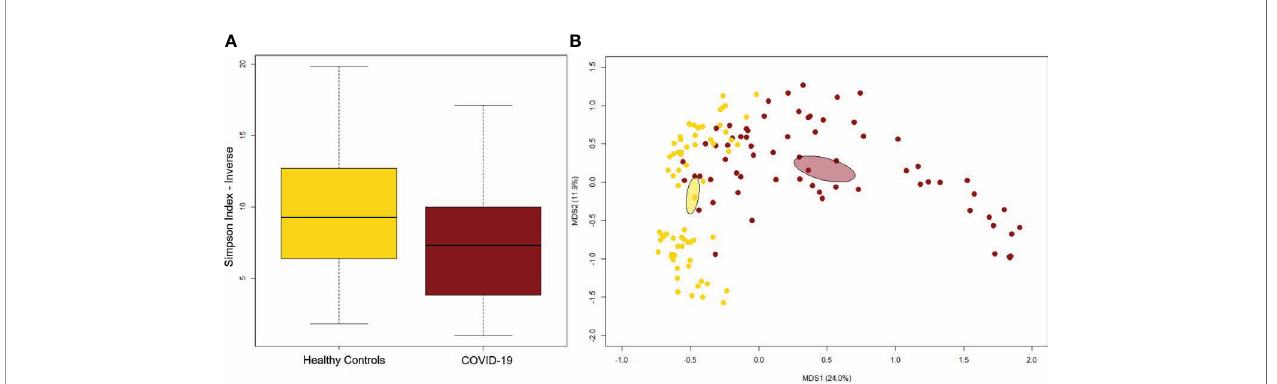
FIGURE 1 | The gut microbiota of COVID-19 patients segregates from that of healthy subjects. (A) Alpha diversity estimated according to the inverse Simpson index. A signi fi cant reduction was observed in COVID-19 patients (p value = 0.0008, Wilcoxon test). (B) Principal Coordinates Analysis (PCoA) based on Bray-Curtis dissimilarity between the genus-level pro fi les. A signi fi cant separation between groups was found (p value = 0.001, permutation test with pseudo-F ratio). Ellipses include 95% con fi dence area based on the standard error of the weighted average of sample coordinates.